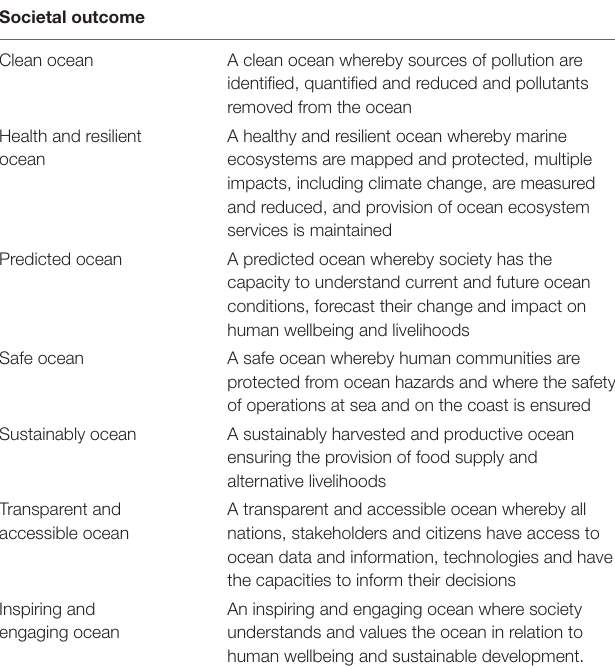
TABLE 1 | The societal outcomes for the UN Decade of Ocean Science for Sustainable Development. Societal outcome Clean